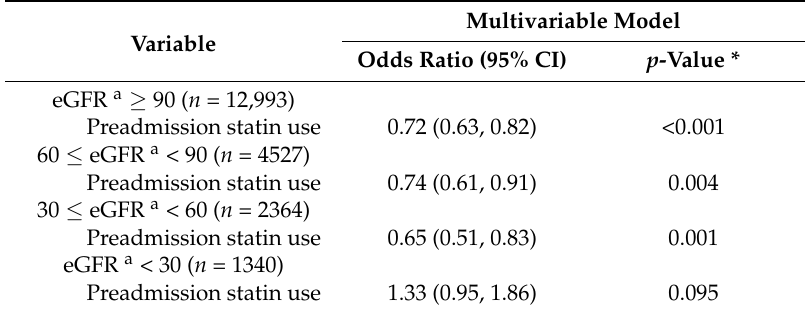
Table 4. Multivariable logistic regression analysis for occurrence of acute kidney injury during 72 h after ICU admission according to eGFR at ICU admission.